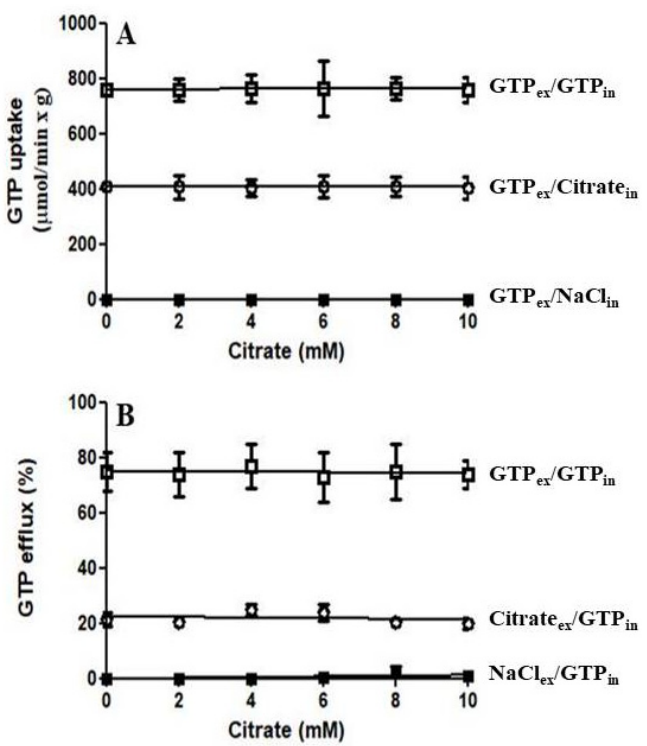
Figure 6. ( A ) The rate of GTP uptake into proteoliposomes reconstituted with Ggc1p is independent of external citrate. Transport was started by adding 1 µ M [8- 3 H] GTP and citrate (0–10 mM) to proteoliposomes containing 5 mM citrate ( ○ ), 5 mM GTP ( □ ) or 5 mM NaCl ( ■ ) and stopped after 20 s; ( B ) The rate of GTP efflux from proteoliposomes reconstituted with Ggc1p is independent of internal citrate. Proteoliposomes were reconstituted in the presence of 0.2 mM GTP and citrate (0–10 mM). The internal GTP pool was labeled by carrier-mediated exchange equilibration. Then the proteoliposomes were passed through Sephadex G-75 columns pre-equilibrated with 50 mM NaCl and 10 mM PIPES pH 7.0. The efflux of [8- 3 H] GTP was started by adding 1 mM citrate ( ○ ), 1 mM GTP ( □ ) or 0.5 mM NaCl ( ■ ) and stopped after 20 s.